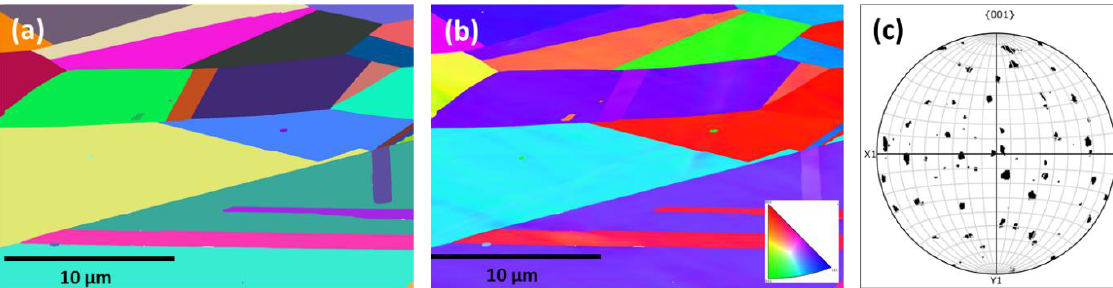
Figure 5. EBSD maps on cast Inconel 718 alloy: ( a ) Grain boundary (GB), ( b ) inverse pole figure (IPF), and ( c ) pole figure (PF) maps.